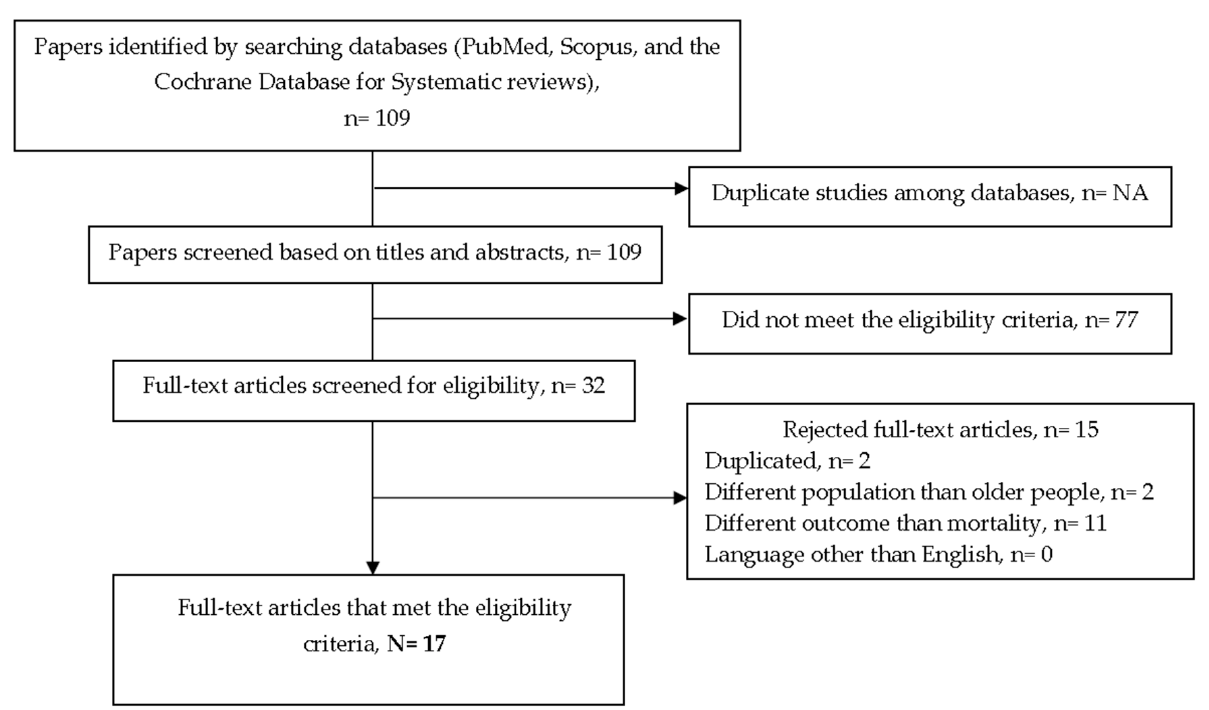
Figure 1. Detailed fl ow diagram of the bibliographic search.